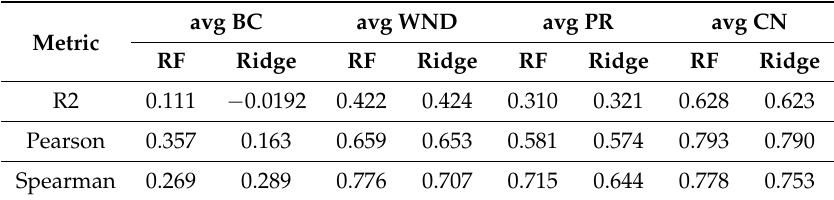
Table 2. Prediction results for structural properties.